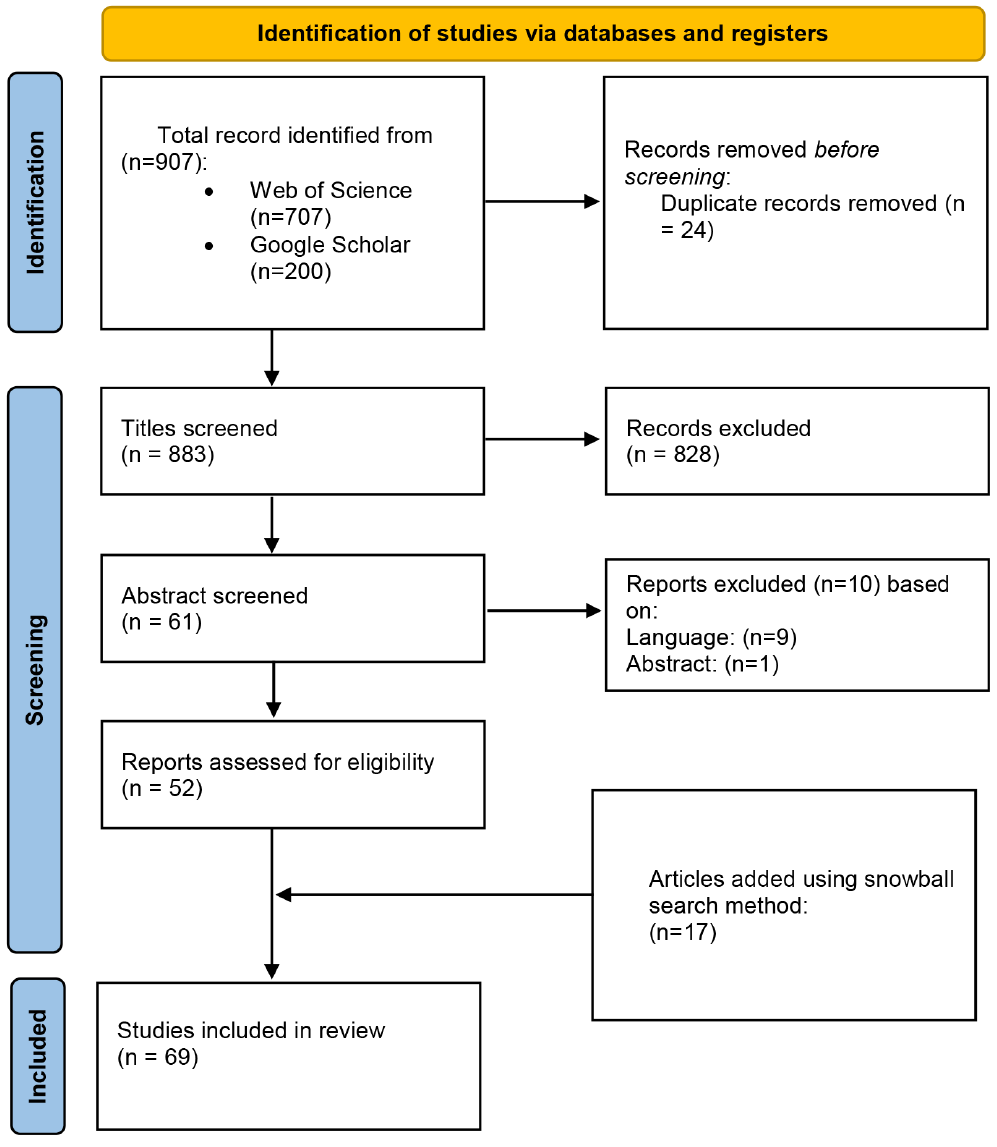
Figure 1. PRISMA Flow